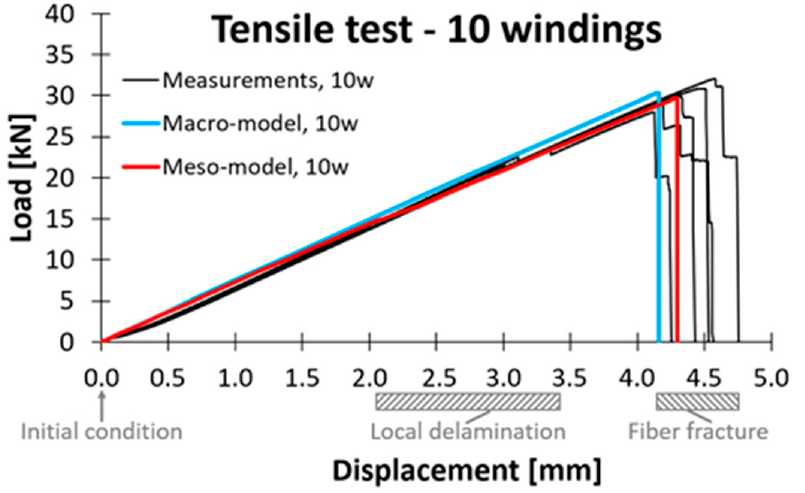
Figure 21. Load-displacement curves from tensile tests on simple loops with ten windings (meas- ured and